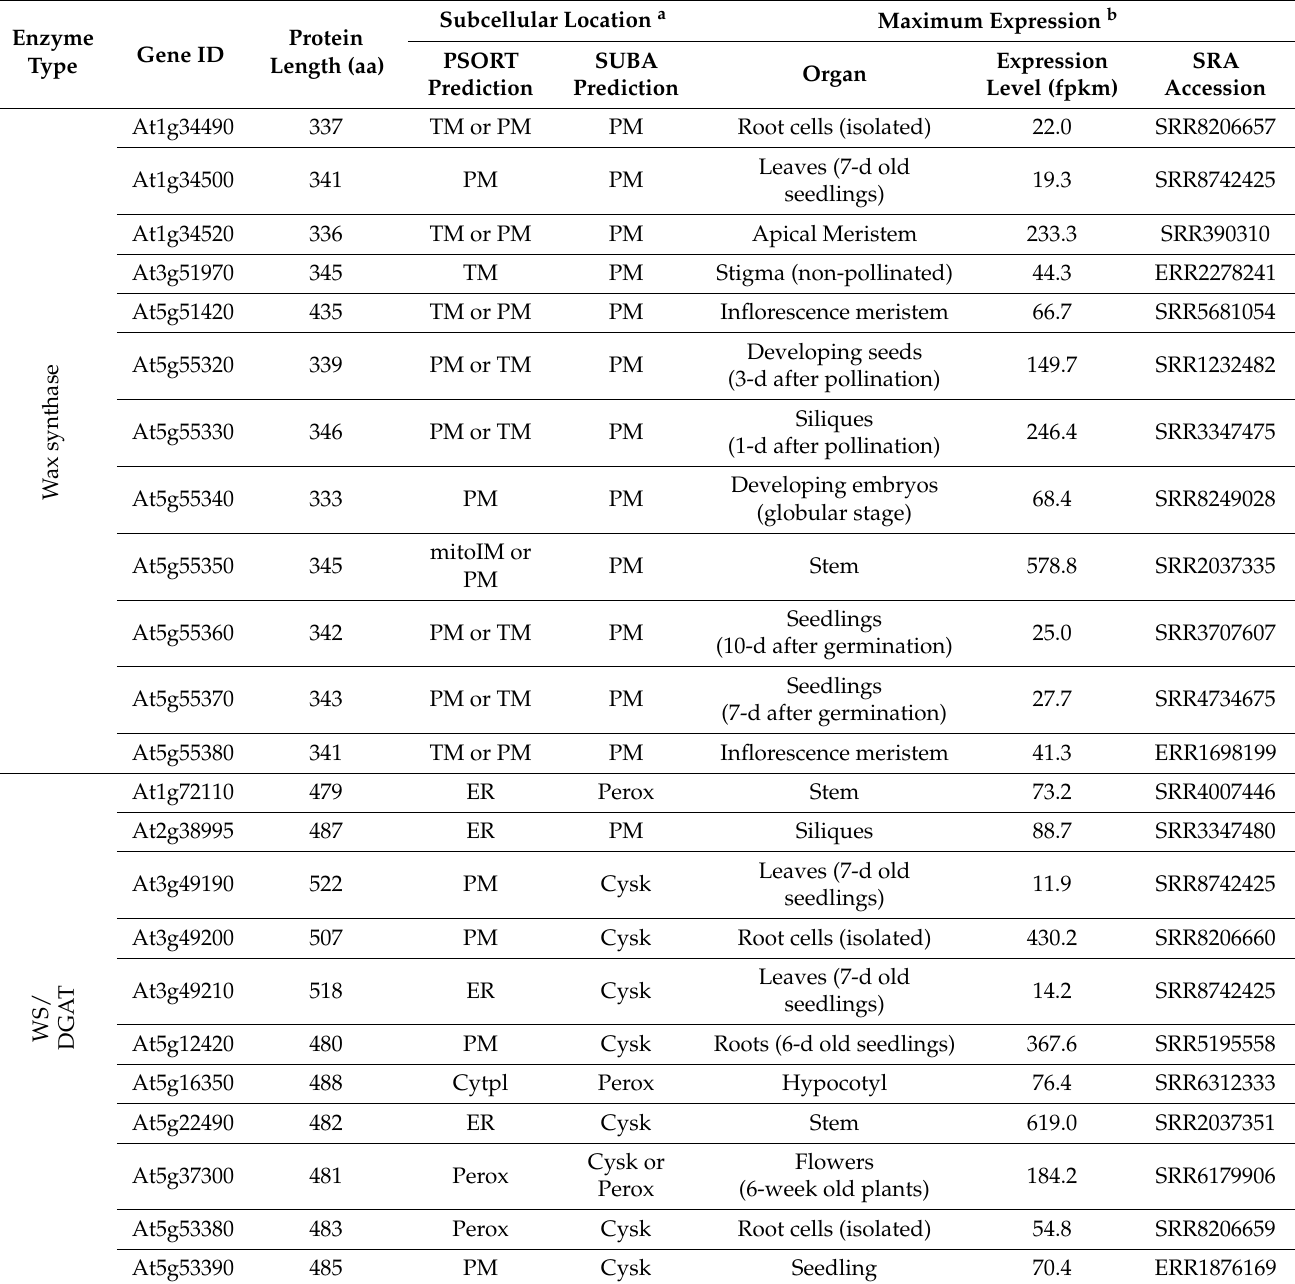
Table 1. Arabidopsis was synthase and bifunctional WSD coding